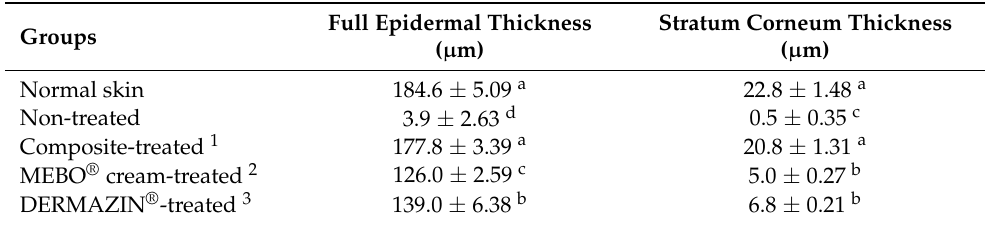
Table 1. Epidermal thickness of normal rabbit skin and different treated groups (TG) in induced skin burns. Values are presented as mean ± SE ( n = 9). Different letters (a, b, c, and d) in the same column indicate significant differences at p < 0.05.